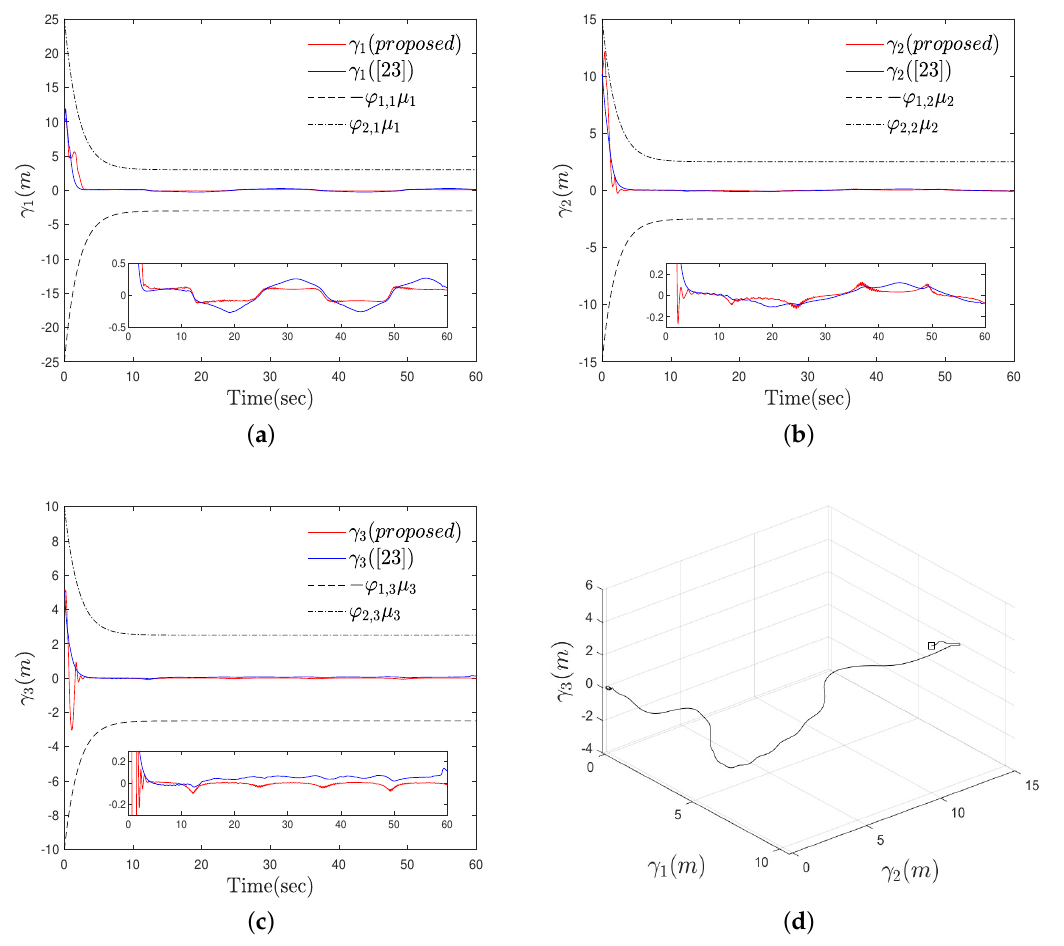
Figure 15. Tracking errors and error phase portraits of the proposed approach for Scenario 3 ( a ) comparison of γ 1 of the proposed approach and the previous approach [23] ( b ) comparison of γ 2 of the proposed approach and the previous approach [23] ( c ) comparison of γ 3 of the proposed approach and the previous approach [23] ( d ) phase portrait of γ 1 , γ 2 , and γ 3 of the proposed